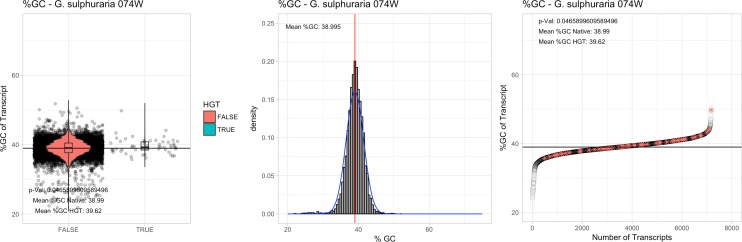
%GC – Galdieria sulphuraria 074W: (Left) Violin plot showing the %GC distribution across native transcripts and HGT candidates.(Mid) Cumulative %GC distribution of transcripts. Red line shows the average, blue line a normal distribution based on the average value. (Right) Ranking all transcripts based upon their %GC content. Red ‘*' demarks HGT candidates. As the %GC content was normally distributed, students test was applied for the determination of significant differences between the native gene and the HGT candidate subset.